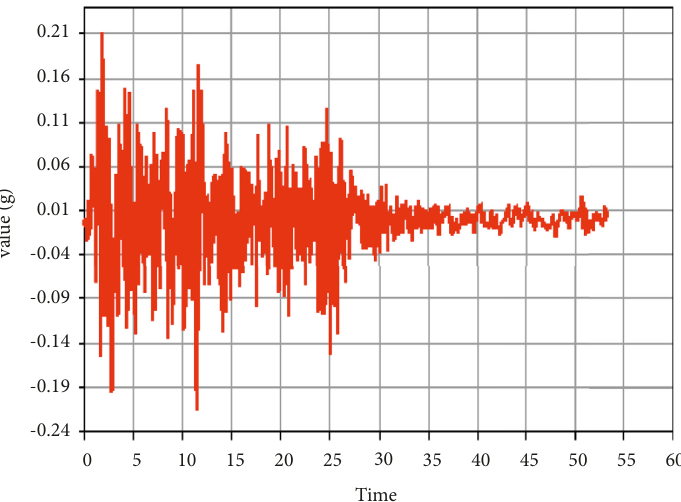
Figure 7: Seismic wave III (0.2114g).